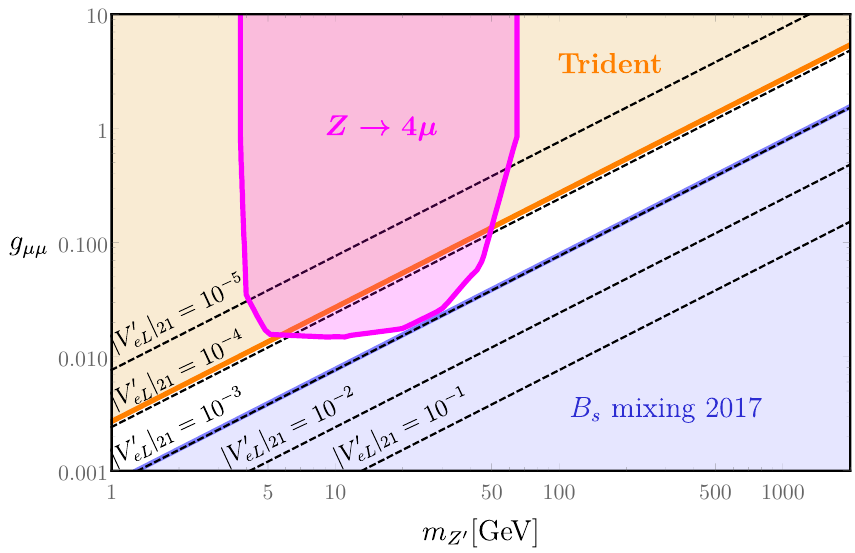
anomalies and K ( (cid:3) )